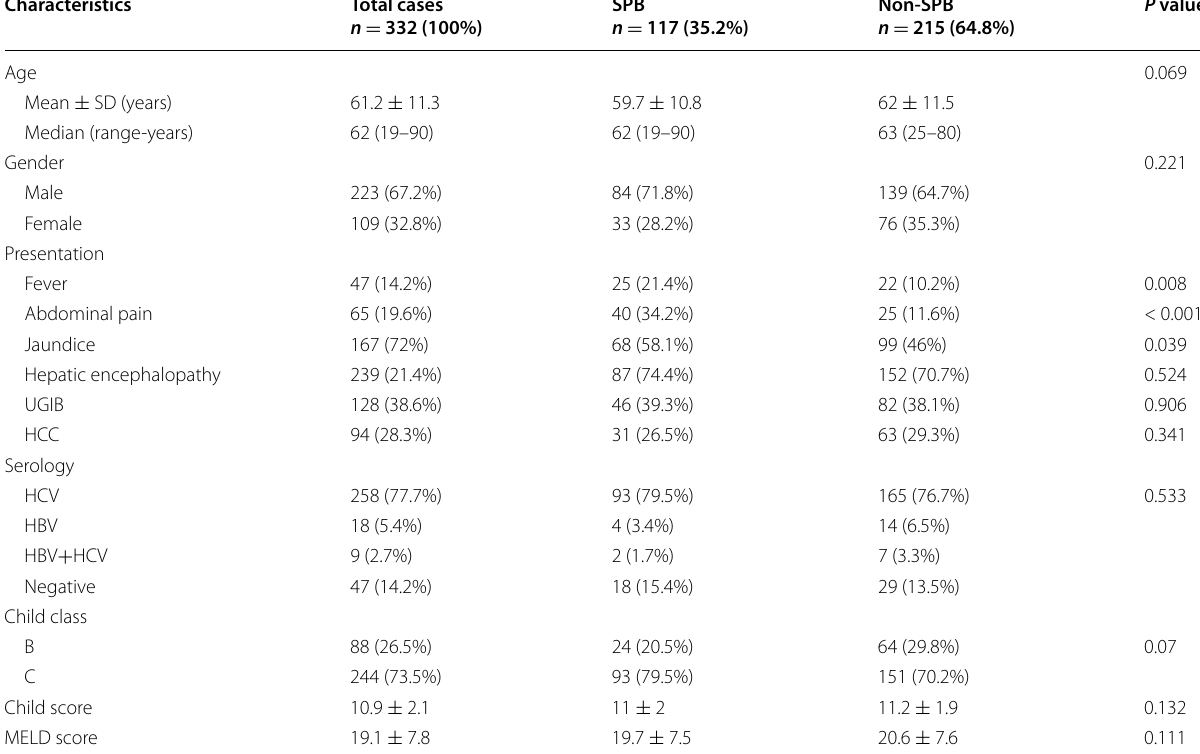
SBP spontaneous bacterial peritonitis, UGIB upper gastrointestinal bleeding, HBV hepatitis B virus, HCV hepatitis C virus, HCC hepatocellular carcinoma, MELD model for end-stage liver disease